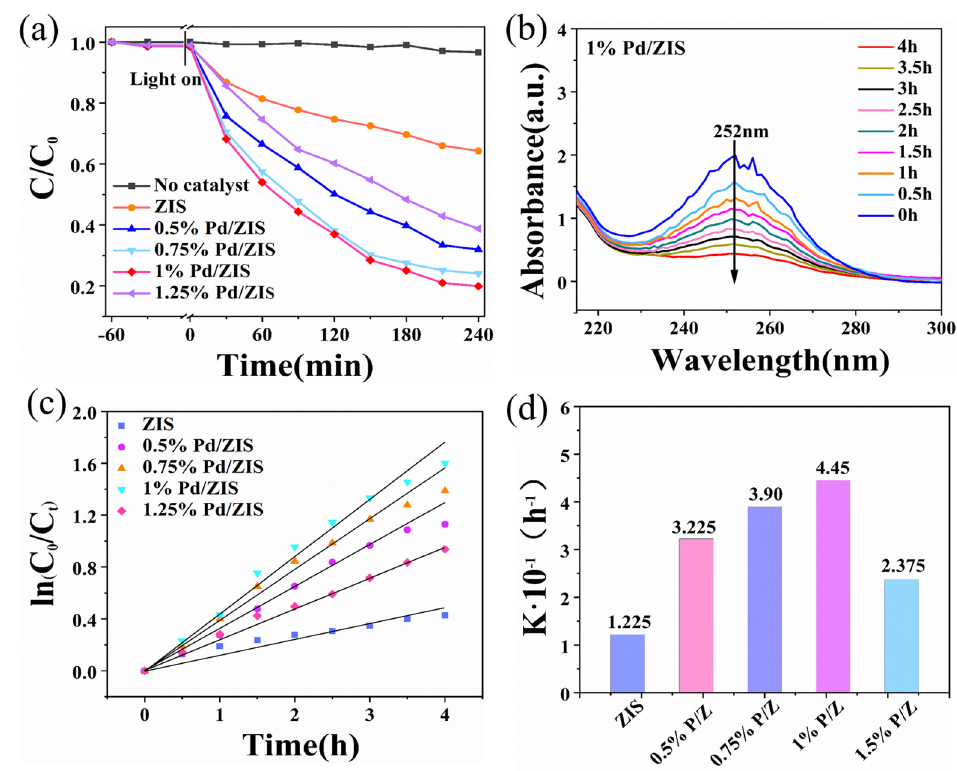
Figure 5. ( a ) Photocatalytic denitrification of pyridine under visible light irradiation; ( b ) UV – vis absorption spectral changes of 1%Pd/ZIS composites; ( c ) corresponding pseudo-first-order kinetics fitting curves of Pd/ZIS composites with different compositions; ( d ) apparent rate constants over different catalysts.